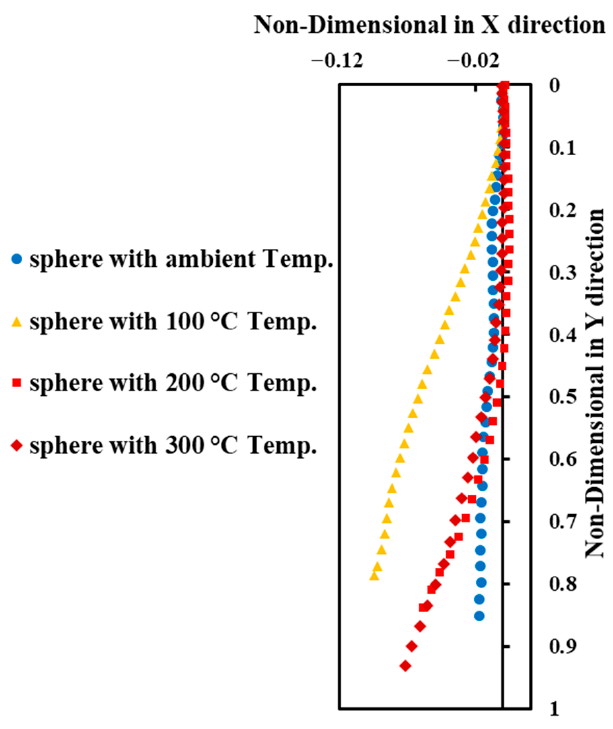
Figure 7. Settling sphere location at different temperatures near the wall.